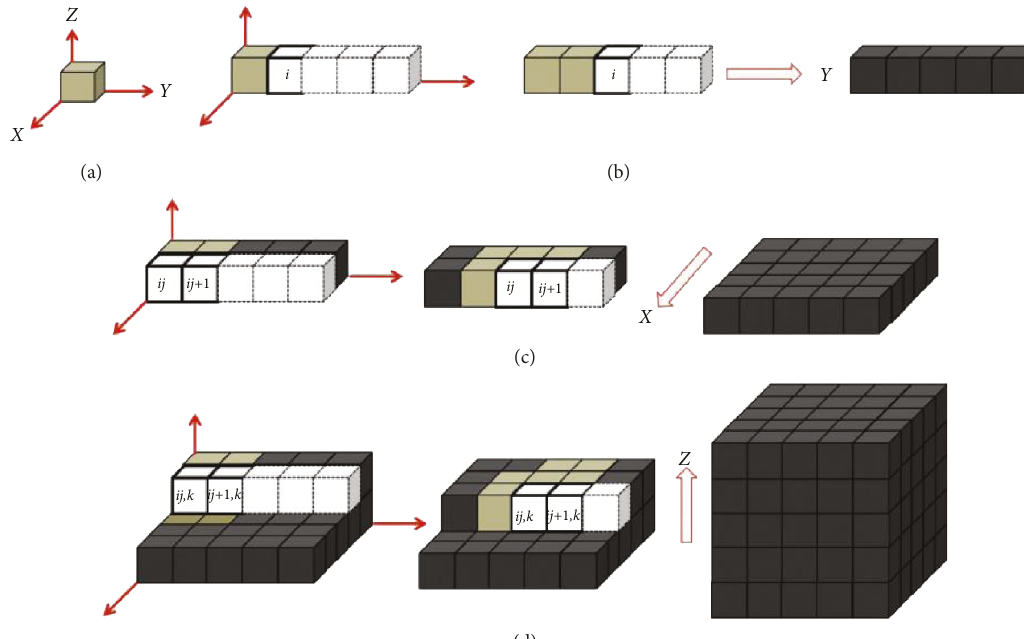
Figure 8: Reconstruction process of 3D digital cores using MCMC reconstruction method. (a) Shows reconstruction the fi rst voxel, (b) shows reconstruction the fi rst row, (c) shows reconstruction the fi rst level, and (d) shows reconstruction the remaining layers of the 3D digital core. Figure from [153].